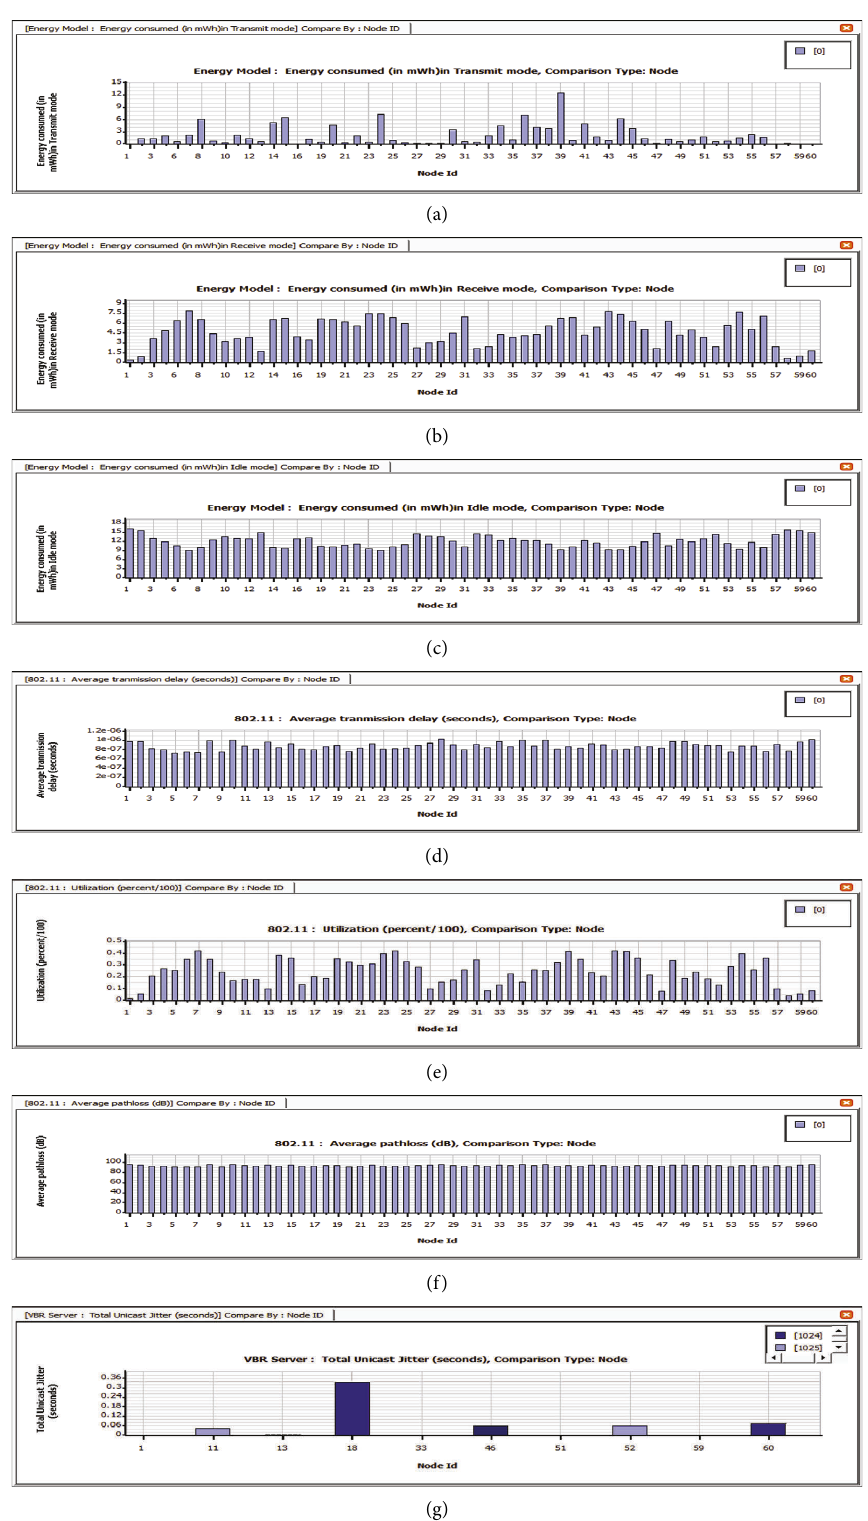
Figure 26: (a) Transmit mode energy consumption of STAR-ORA for VBR deployment. (b) Receive mode energy consumption of STAR- ORA for VBR deployment. (c) Idle mode energy consumption of STAR-ORA for VBR deployment. (d) Average transmission delay of STAR-ORA for VBR deployment. (e) Percentage of utilization of STAR-ORA for VBR deployment. (f) Average pathloss of STAR-ORA for VBR deployment. (g) Average jitter of STAR-ORA for VBR